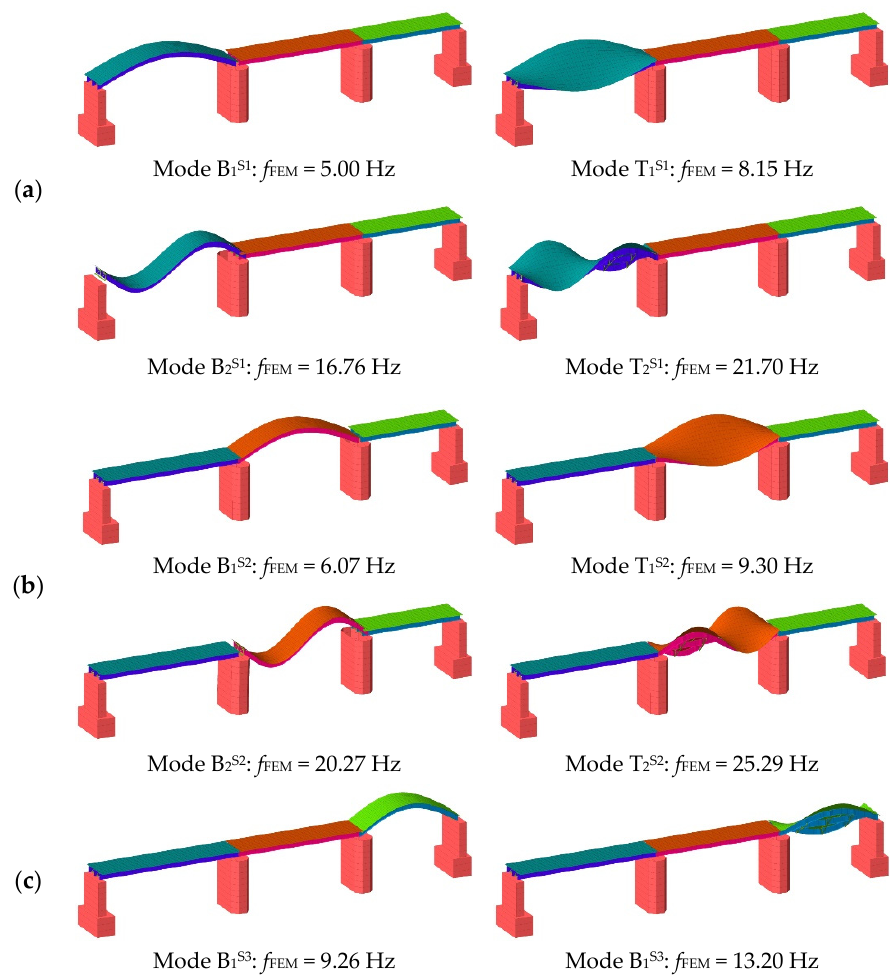
Figure 12. Vibration modes of the updated model: ( a ) Span S1, ( b ) Span S2, and ( c ) Span S3.